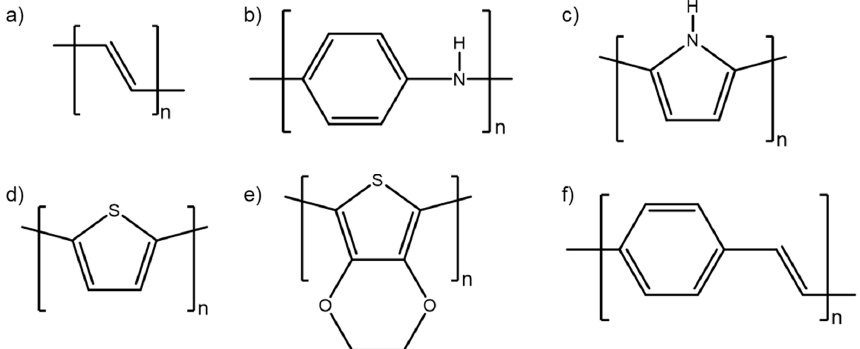
Figure 2. Chemical structures of some common conducting polymers: ( a ) polyacetylene, ( b ) polyaniline (PANI), ( c ) polypyrrole (PPy), ( d ) polythiophene (PT), ( e ) poly(3,4-ethylenedioxythiophene) (PEDOT), and ( f ) poly(phenylene vinylene) (PPV).